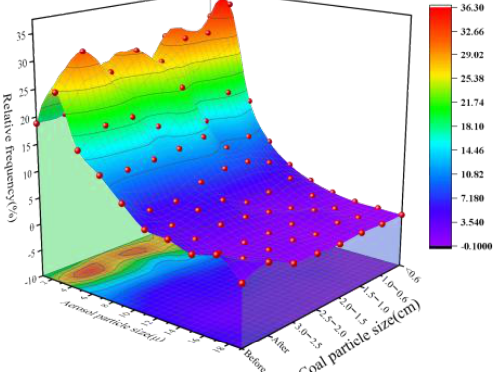
Figure 12. Statistical chart of particle size.